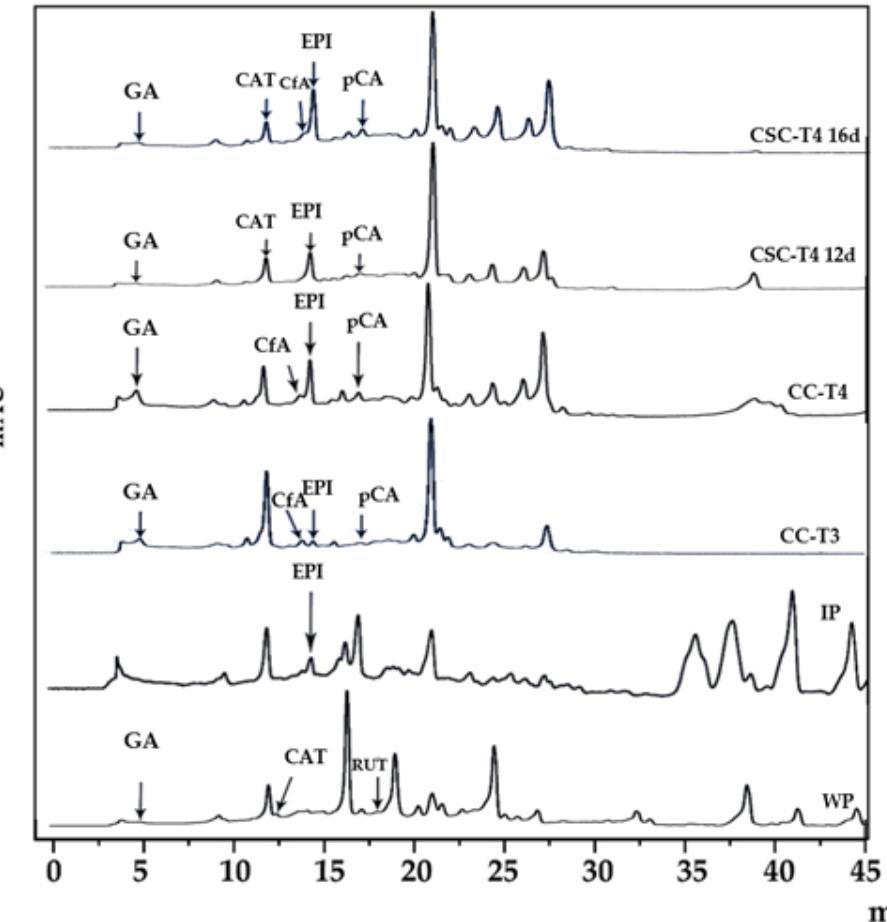
Figure 3. HPLC chromatograms for methanol extracts of A. pichichensis from wild plant (WP), in vitro plant (IP), callus culture (CC-T3 and CC-T4), suspension cell culture (CSC-T4 12d and CSC-T4-16d). Gallic acid (GA), catechin (CAT), caffeic acid (CfA), epicatechin (EPI), p-coumaric acid (pCA) and rutin (RUT). Table 3. Quantitative analysis of identified phenolics compounds of extracts from A. pichichensis wild plant (WP), in vitro plant (IP), callus culture (CC-T3 and CC-T4), suspension cell culture (CSC-T4 12d and CSC-T4-16d).